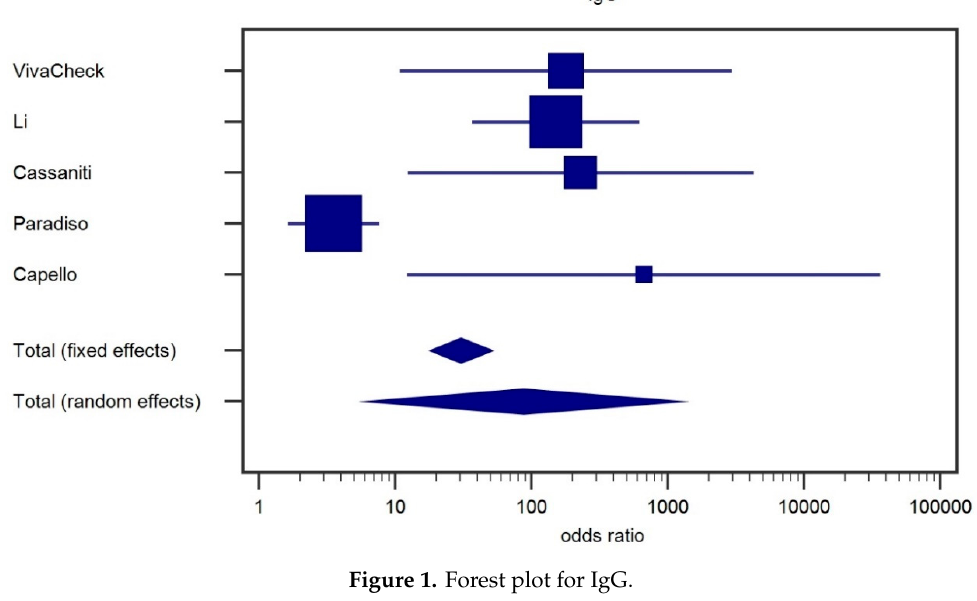
Figure 1. Forest plot for IgG.